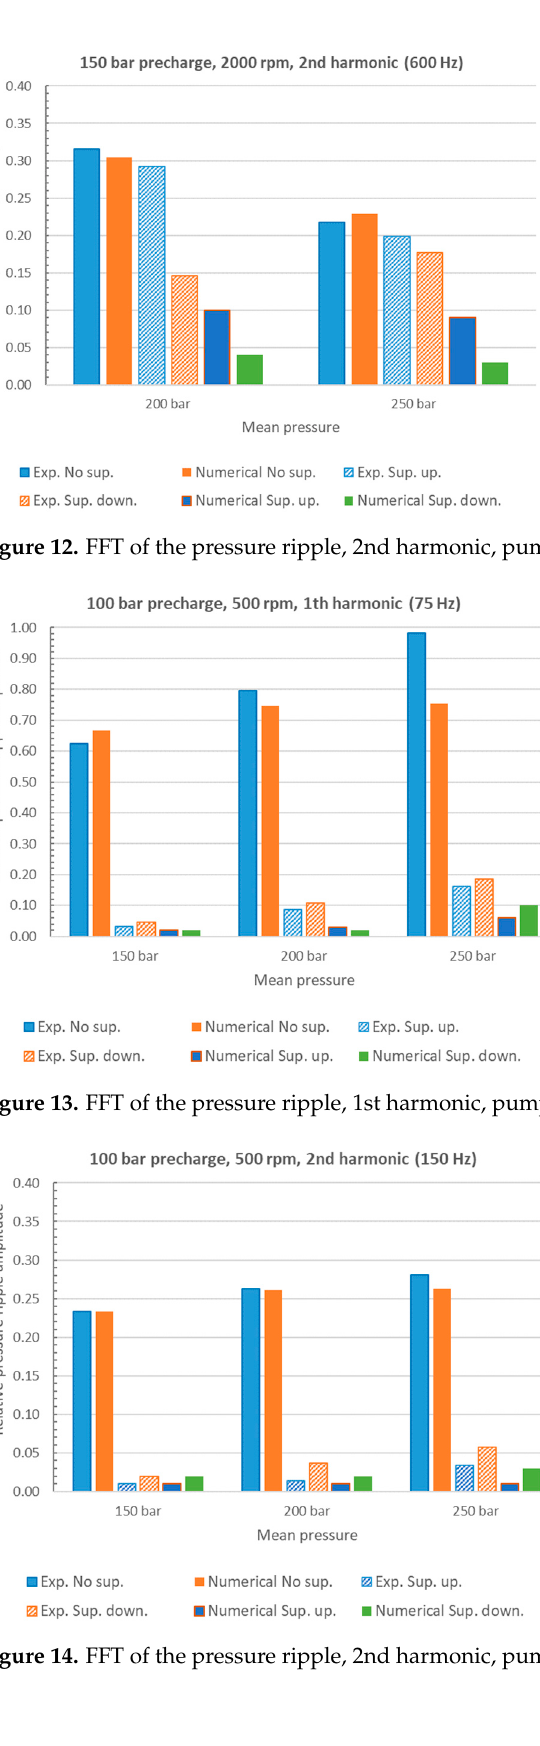
Figure 11. FFT of the pressure ripple, 1st harmonic, pump speed = 2000 rpm.